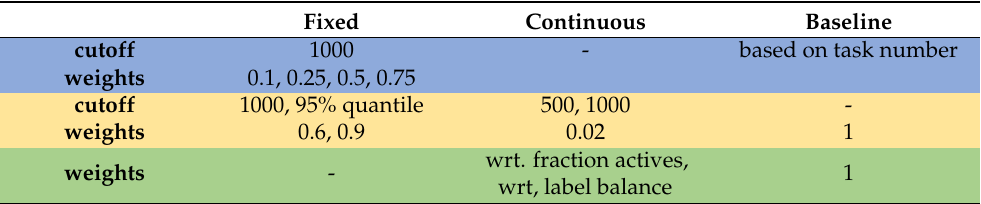
Table 1. Overview of analyzed weighting schemes. Experiments were performed in three phases blue: I, yellow: II, green: III. “Cutoff” determines the task size threshold above which down-weighting according to weights was applied either only once (fixed scheme) or as often as “cutoff” fit into the task size (continuous scheme).